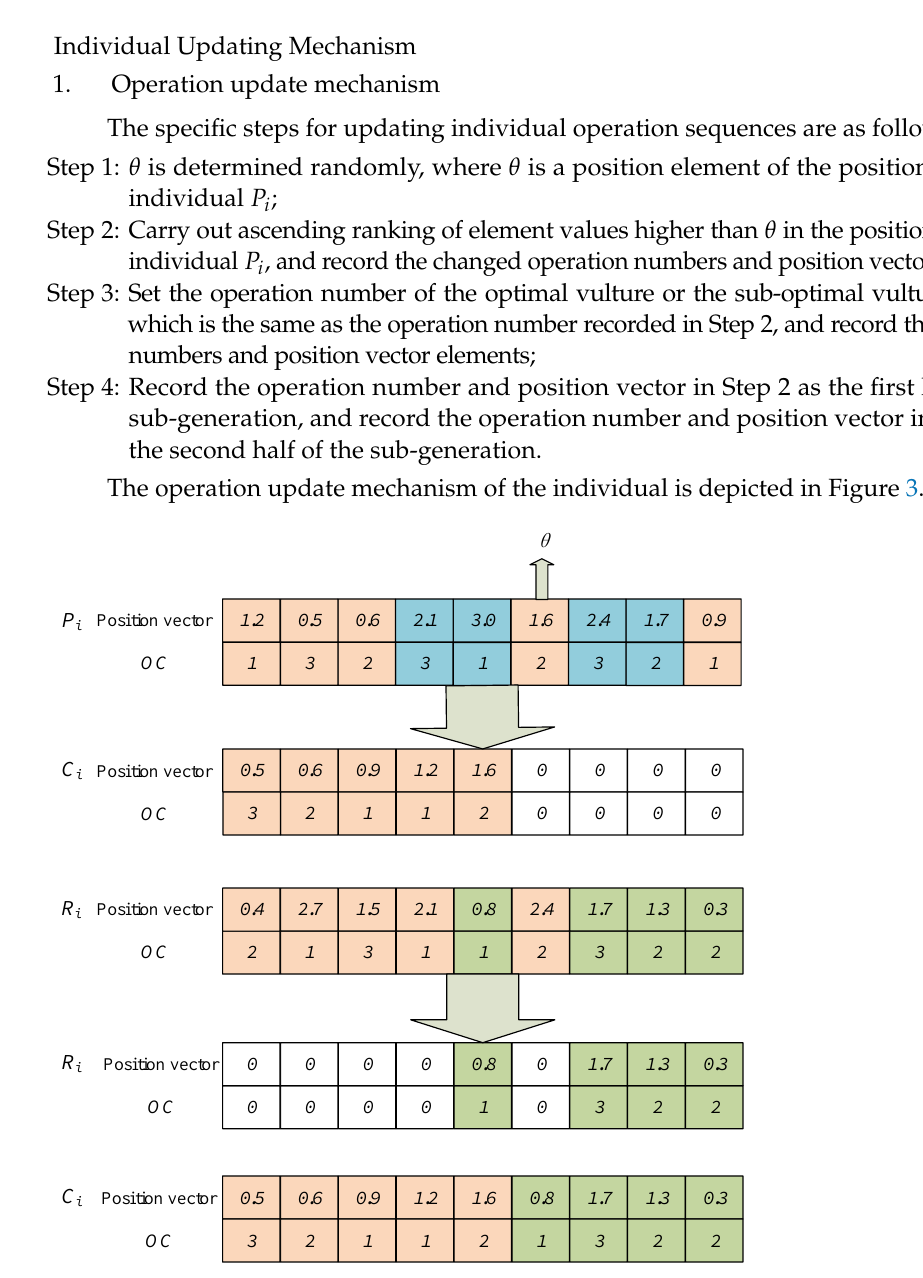
Figure 3. Operation update mechanism of the individual.